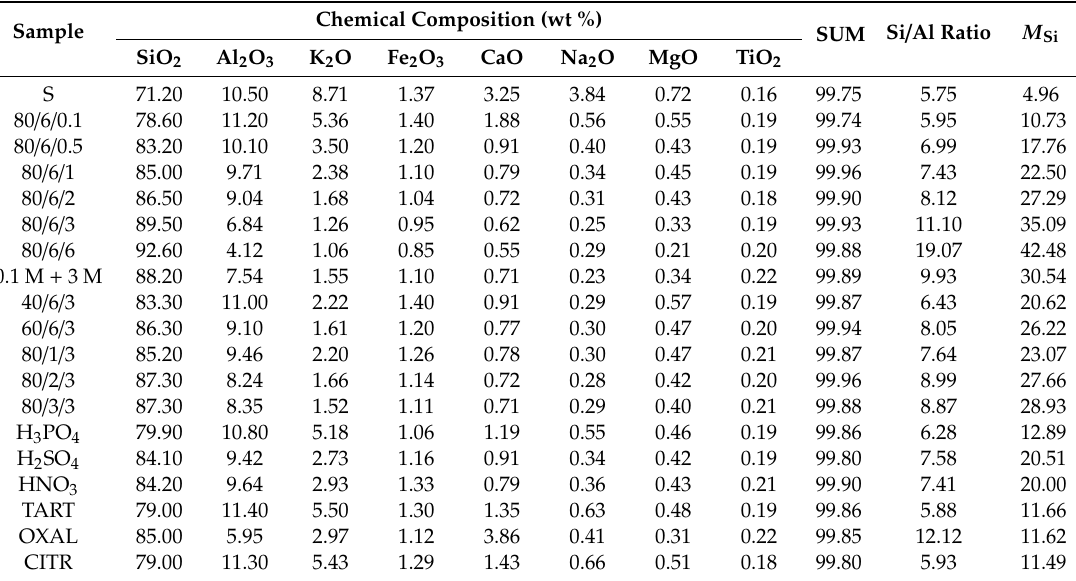
Table 2. Chemical composition of acid leached zeolite foam